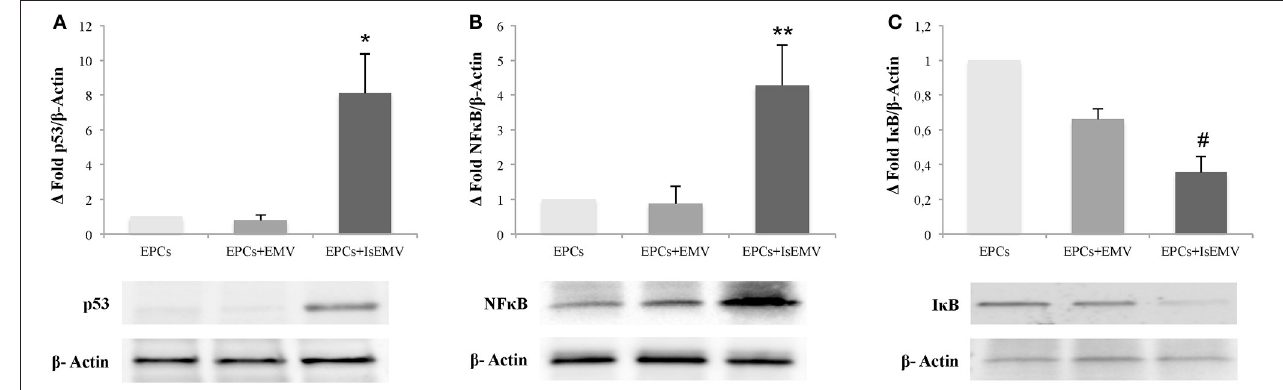
FIGURE 7 | Microvesicles (MV) modulated p53, NF κ B, and I κ B α in endothelial progenitor cells (EPCs). Representative western blots and densitometry analysis of blots for (A) p53, (B) NF κ B, and (C) I κ B α . β -Actin was used as an internal control. IsEMV induced a significant increase in p53 and NF κ B expression and significant decrease in I κ B α expression in EPCs. Data are the means ± SEM of three independent experiments. * p = 0.033 vs. EPCs treated with MV derived from untreated HUVECs (EMV); ** p = 0.022 vs. EPCs treated with EMV; and # p = 0.044 vs. EPCs treated with EMV.